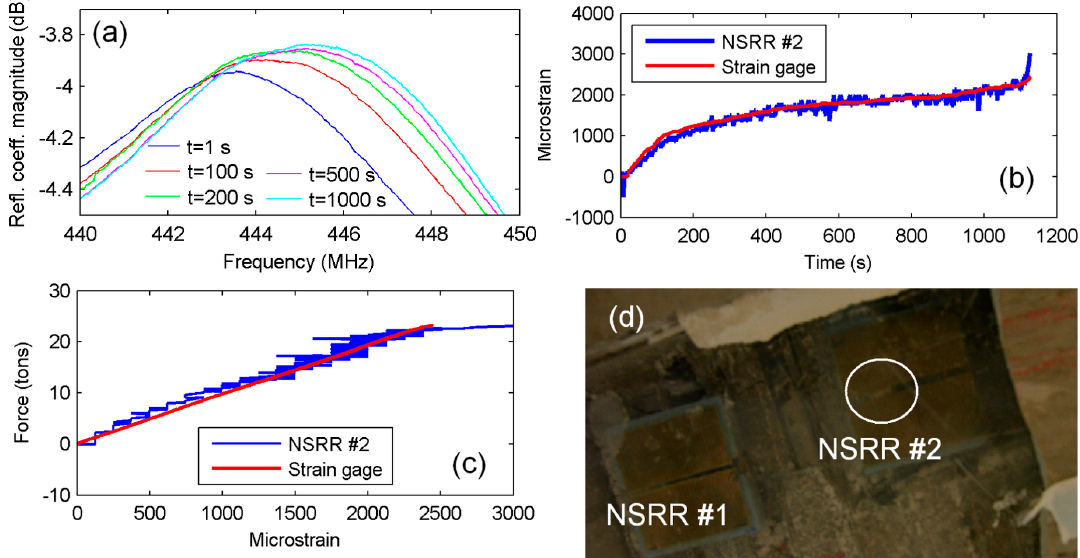
Figure 10. Plastic deformation region measurements: ( a ) NSRR #1 resonance peaks at several time instants; ( b ) strain obtained by NSRR #1 is plotted versus time and is compared with the data from the strain gages until the strain gages break down; ( c ) the force–strain curve plotted with both NSRR #1 and strain gage data; and ( d ) the piece of concrete stuck in NSRR #2 during the experiment.